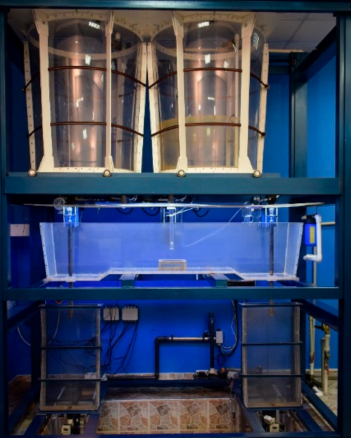
Figure 2. Water model of continuous-casting machine (scale 1:3) at the Faculty of Materials, Metallurgy, and Recycling, Technical University of Košice.